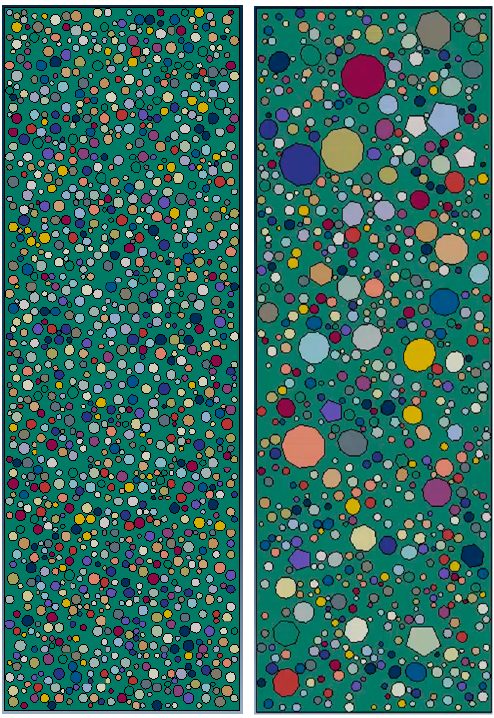
Figure 3. Schematic diagram of aggregate feeding of structural grout material ( left ) and concrete ( right ).